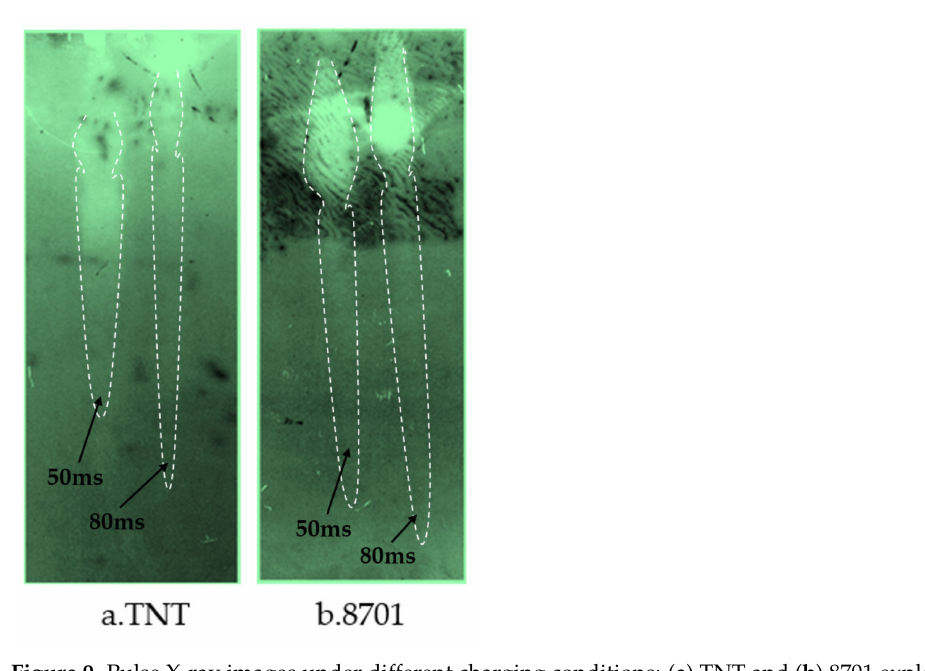
Figure 9. Pulse X-ray images under different charging conditions: ( a ) TNT and ( b ) 8701